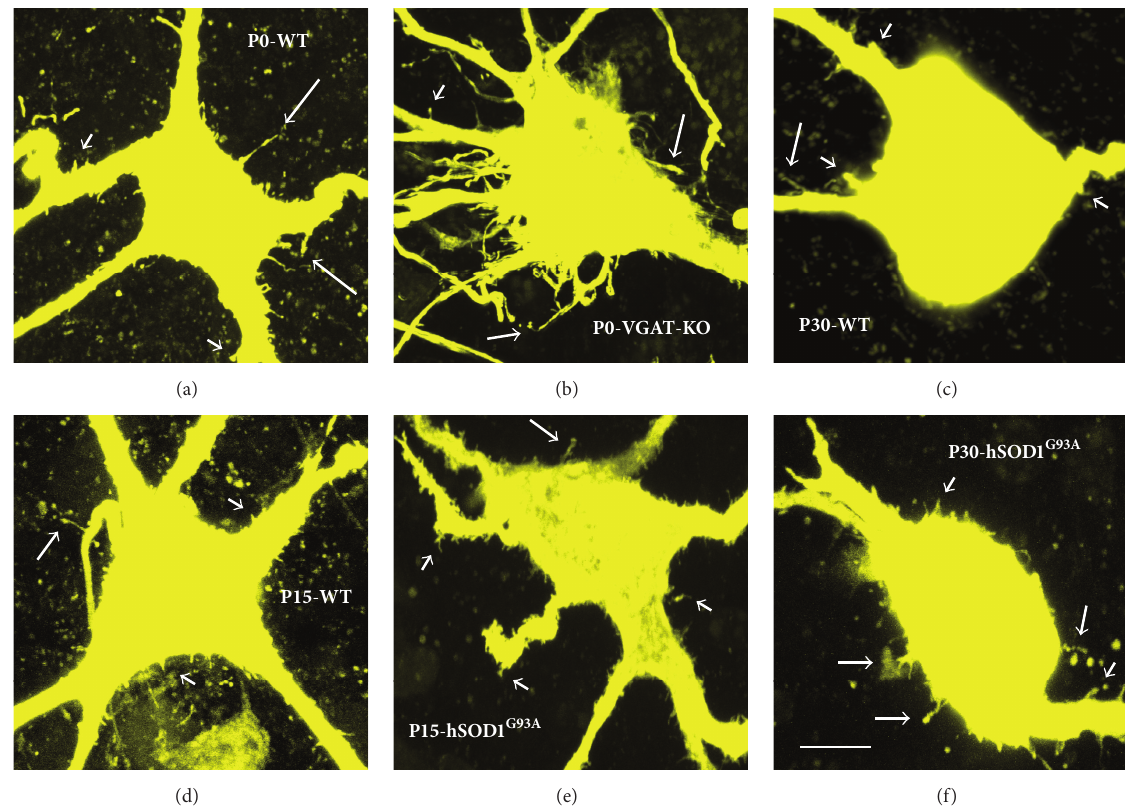
Figure 5: Somatodendritic morphologies of hypoglossal motoneurons during postnatal development and under neuropathological conditions. (a) Filopodia (long arrows) and spine-like processes (short arrows) in the somatodendritic domain of a motoneuron from a P0 WT mouse. (b) Increased density and size of filopodia and spine-like processes from a P0 mice lacking vesicular inhibitory amino acid transporter(VGAT-KO).(c-d)Filopodiaandspine-likeprocessesinthesomadecreaseindensityandsizeduringpostnataldevelopmentfrom WT mice at P15 (d) and P30 (c). (e-f) Density and size of filopodia and spine-like processes are higher in motoneuronal somatodendritic domain in mice overexpressing the mutated human Cu/Zn-superoxide dismutase (hSOD 1 G 93 A ) gene at P15 (e) and P30 (f). All micrographs are assembled from confocal image stacks of 20 to 40 optical images collected at 0.35 𝜇 m steps using an Olympus BX61 (Olympus Fluoview ver. 1.7c) microscope. Scale bar in (f) = 10 𝜇 m (applies to all